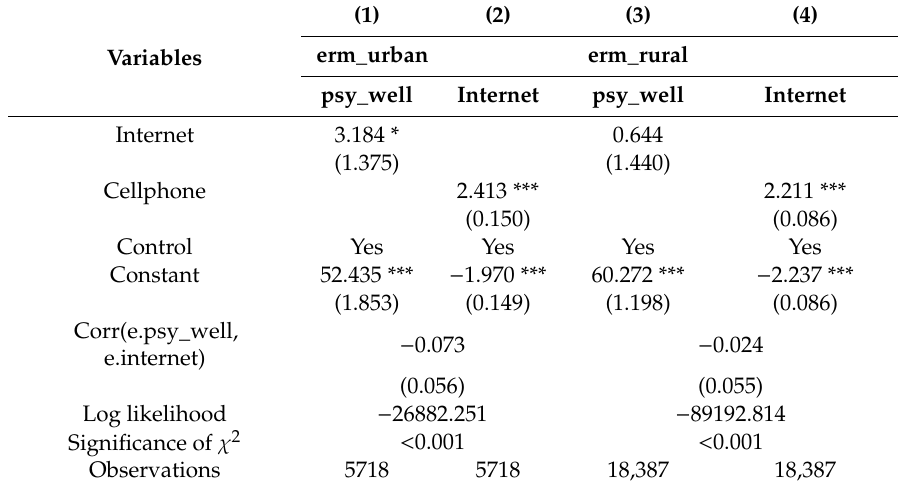
Table 7. Extended regression model to address any potential concerns about